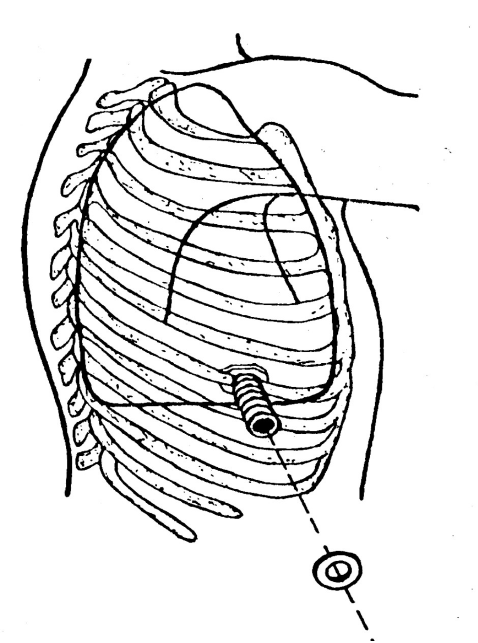
Figure 2 - Schematic representation of POP and its fixation after a 3 cm segment of a rib had been